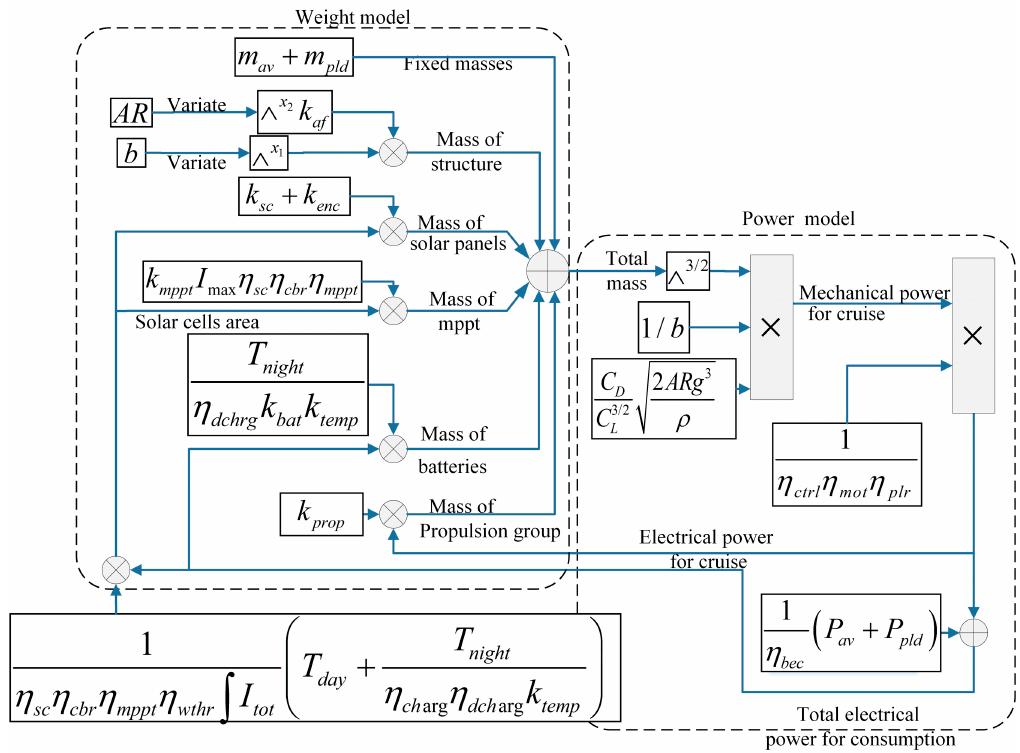
Figure 5. Conceptual design progress of solar-powered UAV based on energy balance.